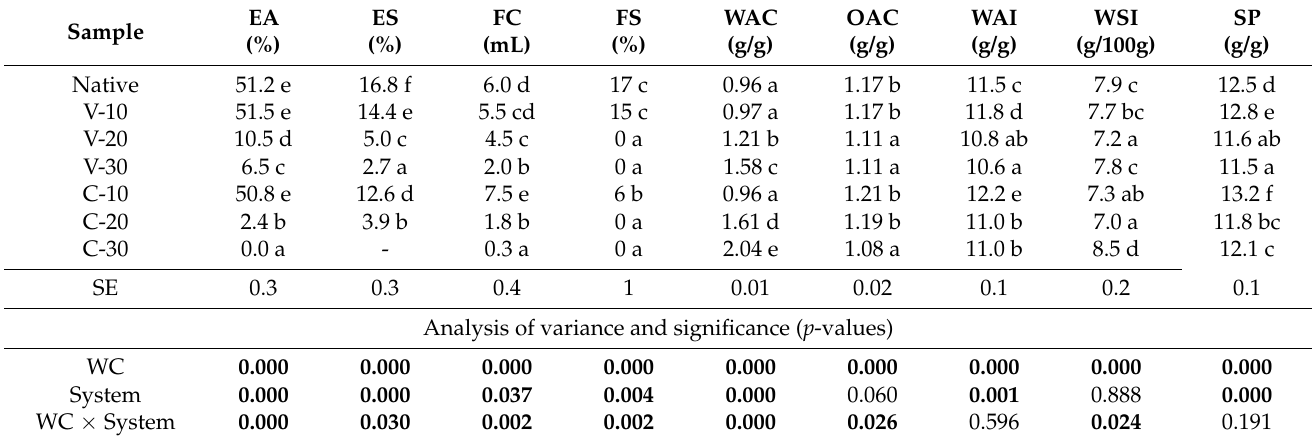
Table 2. Techno-functional properties of flour samples obtained from untreated (native) and microwave-treated quinoa